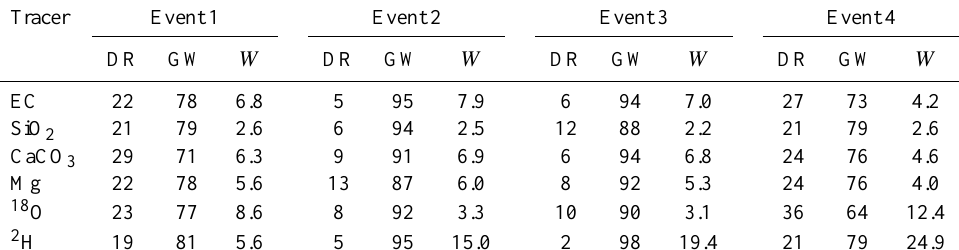
Table 5. Percentages of direct runoff (DR) and groundwater (GW) contributions and 70% uncertainty percentages ( W ) from two-component hydrograph separations for the 2013–2014 wet season, Kaap catchment, South Africa.